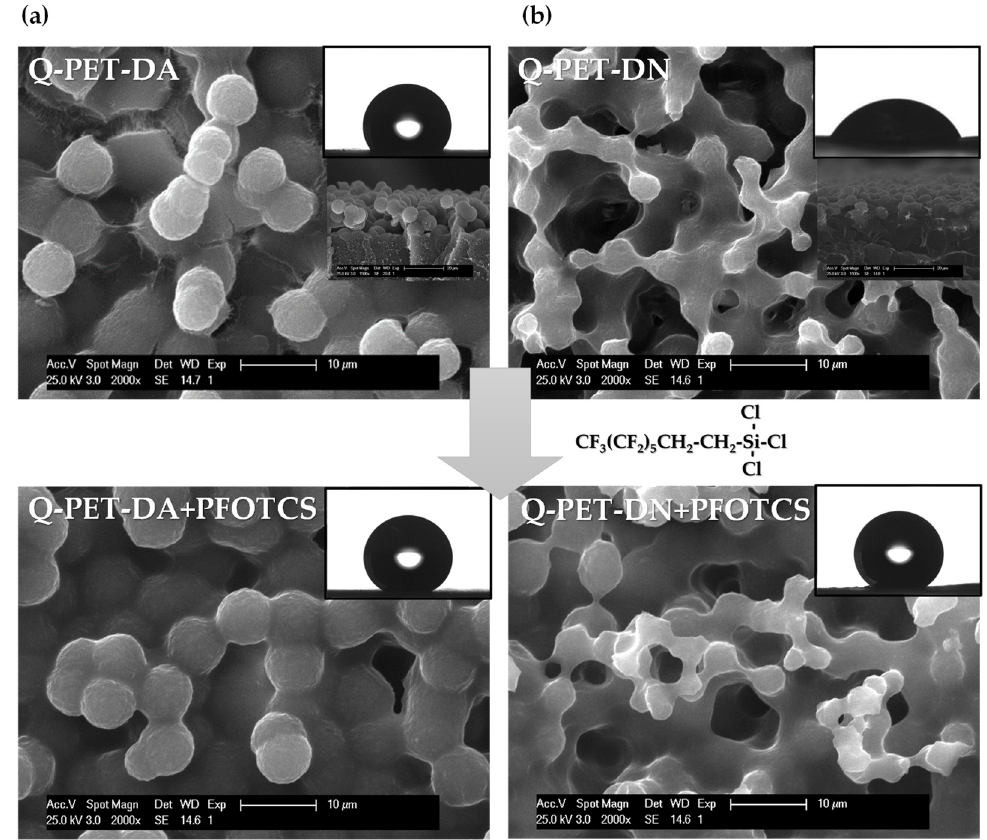
Figure 5. SEM micrographs of the surface and the section of the surfaces after the skin removal treatment: Q-PET-DA ( a ) and Q-PET-DN ( b ); and after the PFOTCS modification ( down ).